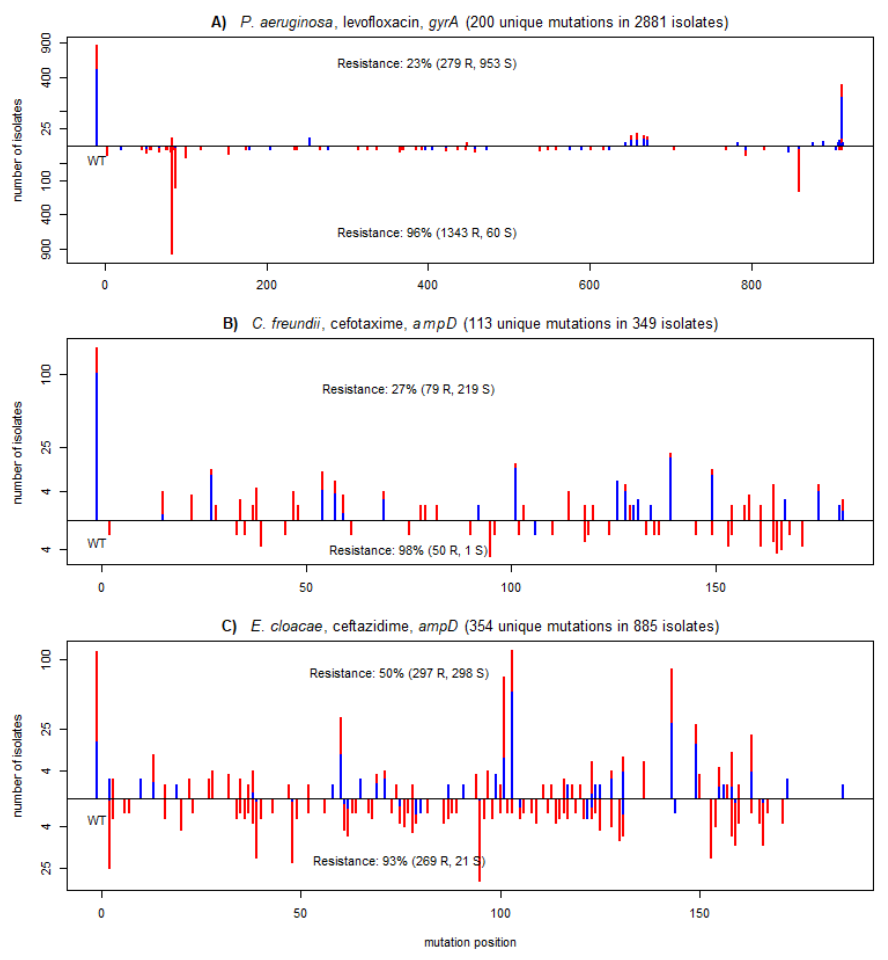
Figure 4. Mutational profiles across the three most important genes of the models for the following combinations: ( A ) P. aeruginosa , ciprofloxacin; ( B ) C. freundii , cefotaxime; and ( C ) E. cloacae , ceftazidime. Each plot shows the positional distribution of mutations of the most important gene for the model prediction. The bars show the number of assemblies having a given mutation at a given position, but only considering the most damaging mutation per assembly. Damaging mutations (PROVEAN scores lower than a gene specific threshold used by XGB models) are shown on the negative y-axis section; neutral mutations (score larger than or equal to the threshold) are shown in the positive y-axis section. The y-axis is shown in a square root scale. Red and blue colors correspond to assemblies resistant and susceptible to the given compound. The number of isolates identified as damaging or neutral along with the percentage of resistant isolates are shown for each group. Isolates with wild-type sequences are positioned at position -10 on the x-axis and labelled WT.